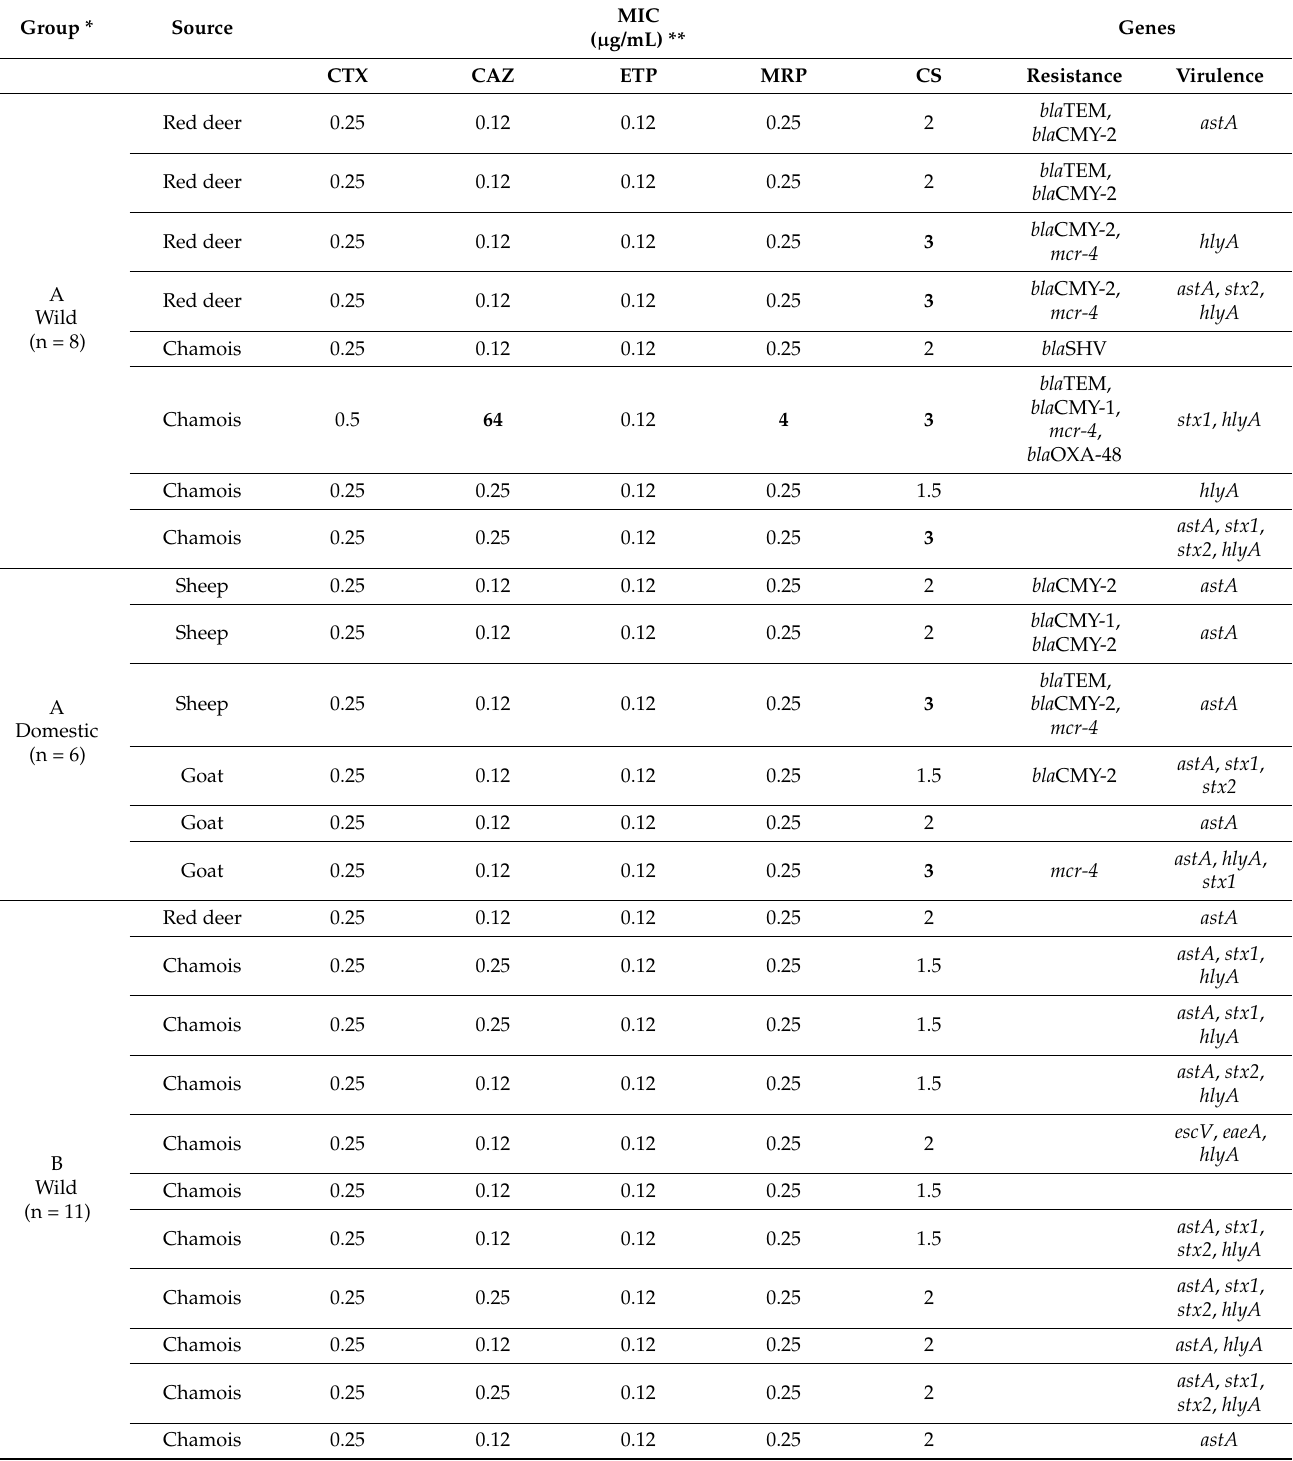
Table 3. Details of animal source, Minimum Inhibitory Concentration (MIC) values, resistance and virulence genes among 38 E. coli isolates from two groups of wild and domestic